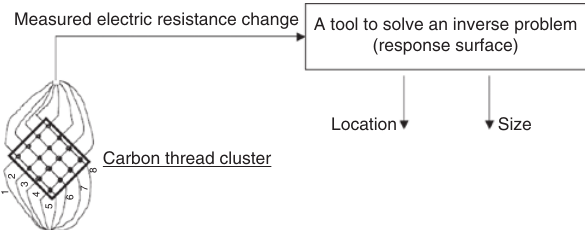
Figure 4: Schematic representation method using an electric resist- ance change